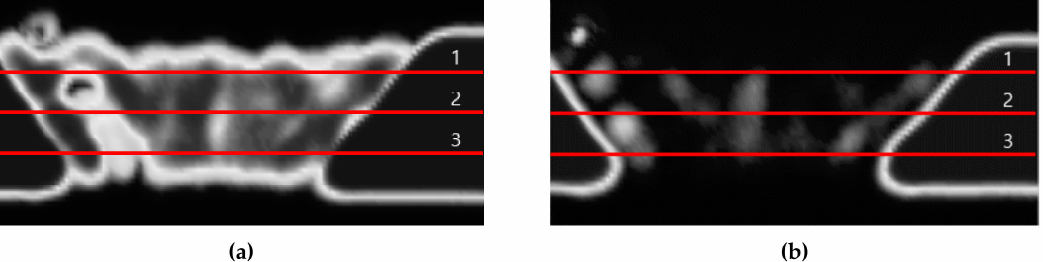
Figure 13. Ultrasonic images by ( a ) the first back-surface echo and ( b ) second back-surface echo with three horizontal lines divided into four equal intervals.